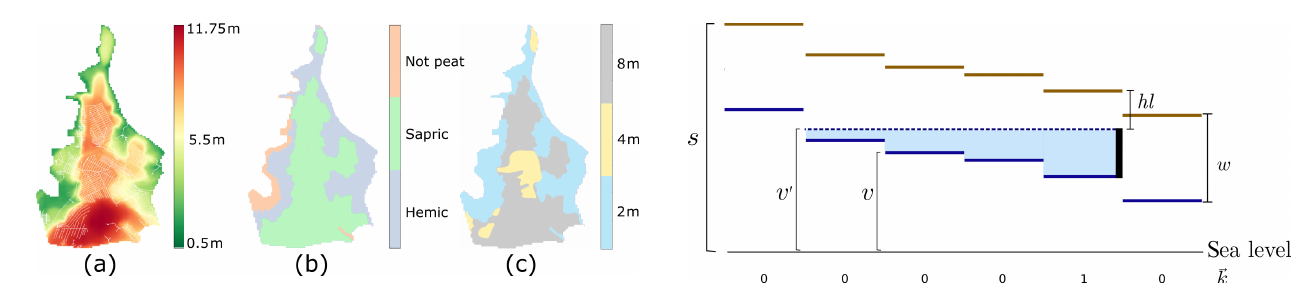
Figure 4. Side view of a canal. The solid blue and the brown hori- zontal lines represent the initial CWL, v , and the height of the peat surface, s , respectively. The parameter w denotes the distance from the peat surface to the CWL. Each pixel is represented by one line segment. The vertical black line represents the block, and the dot- ted blue line represents the CWL after the block has been placed, v (cid:48) . The shaded blue area represents the change in the CWL due to the block. The value of the vector k is k i = 1 if there is a block in pixel i and otherwise k i =